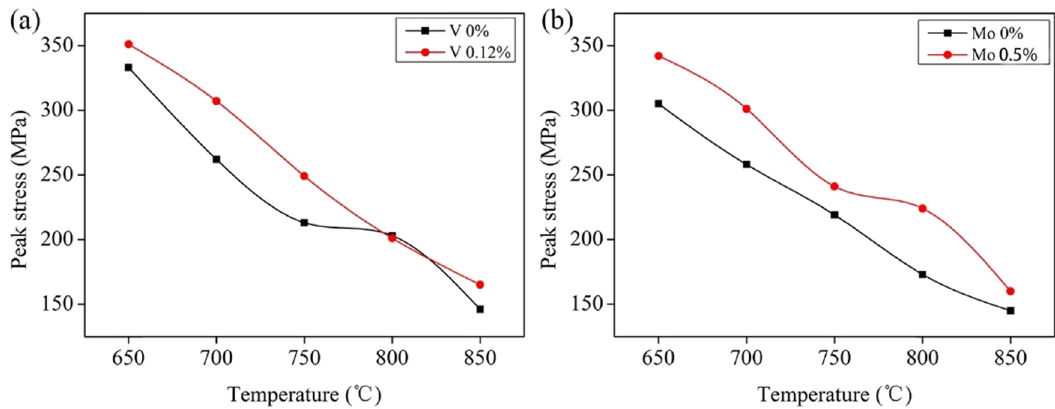
Figure 13: Peak stress curves with a strain rate of 0.005 s − 1 : ( a ) steel 5# and 6#; ( b ) steel 7# and 8#.